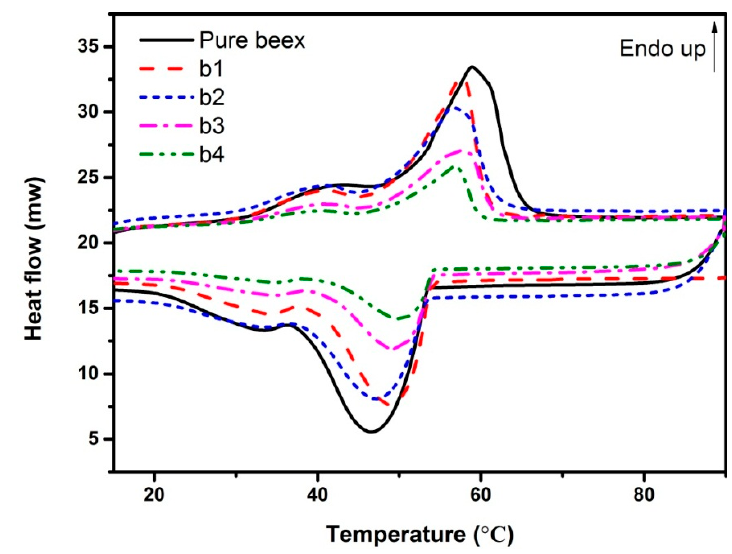
Figure 8. The melting and solidifying DSC curves for the beeswax/AgBr microcapsules. Table 3. DSC data for the prepared beeswax/AgBr micro/nanocapsules.